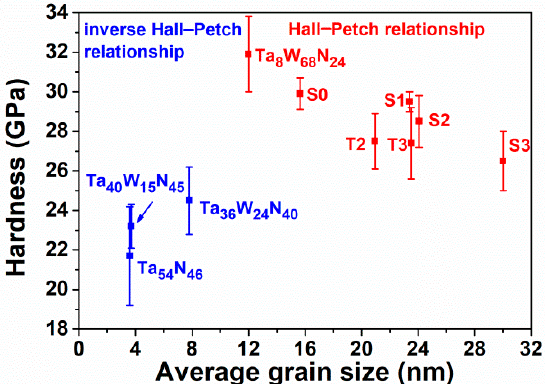
Figure 9. Variations in hardness and average grain size in relation to the Si content of the TaWSiN films.